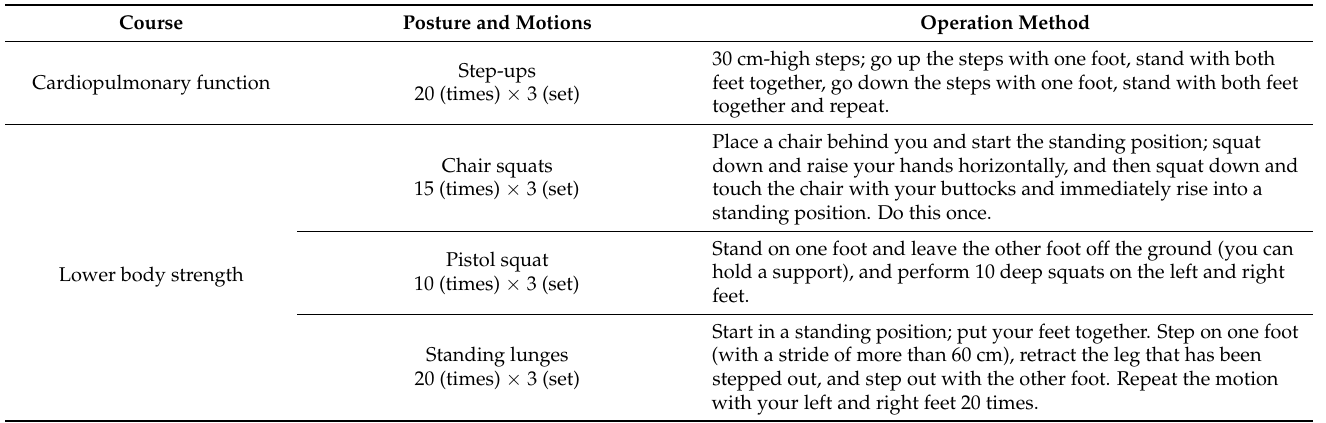
Table 2. Physical activity